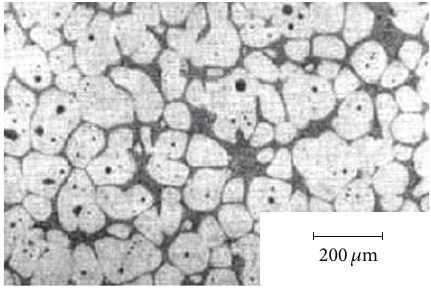
Figure 7: Microstructure of AlSi7Mg0.6 (A357) alloy billets obtained by MHD stirring